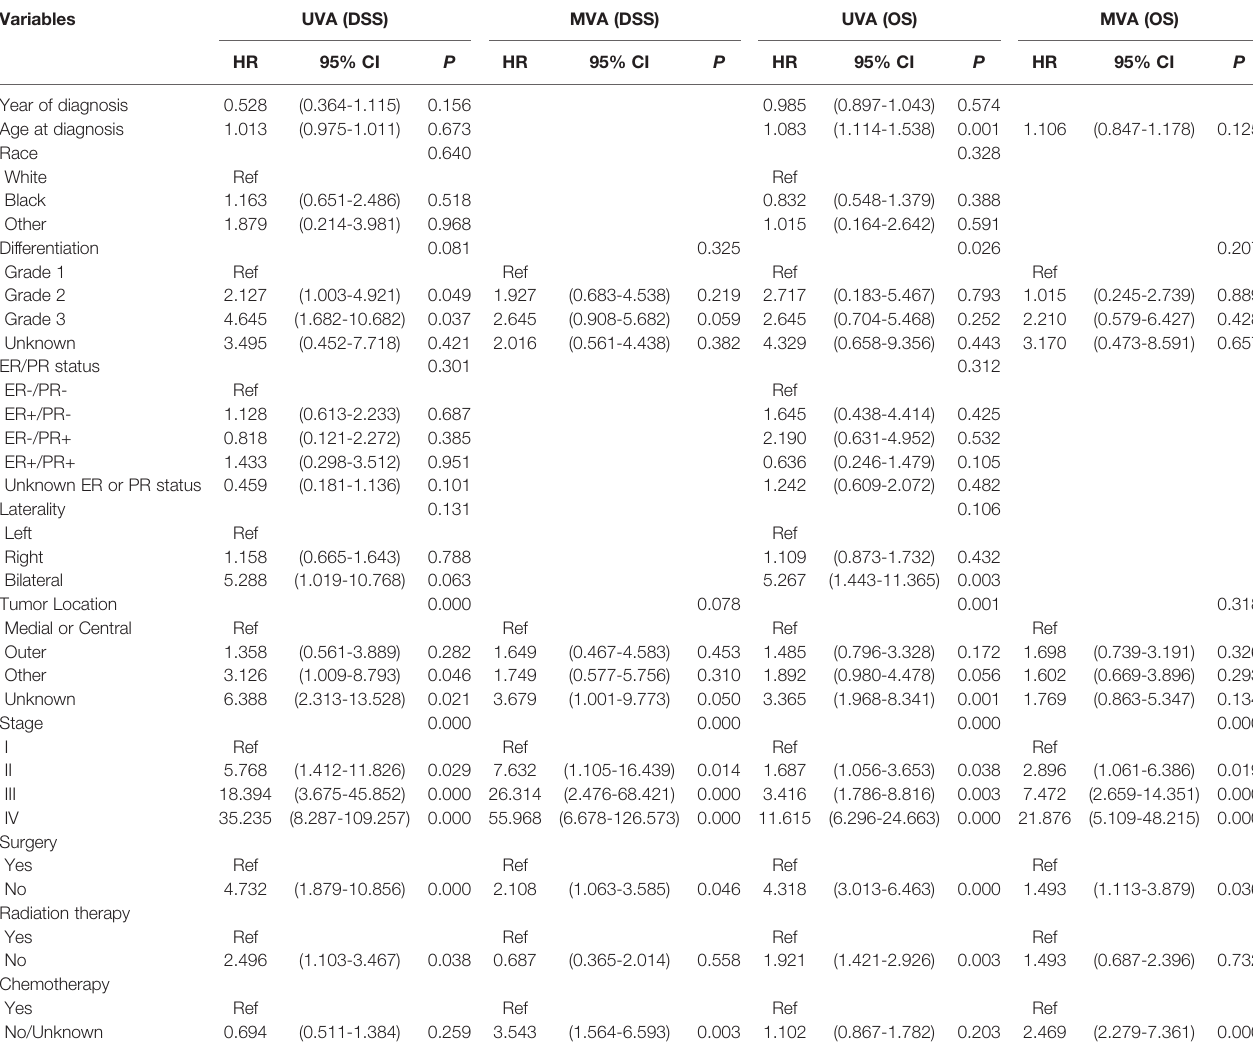
TABLE 2 | Univariate and multivariate analysis for disease speci fi c survival and overall survival with training cohort.